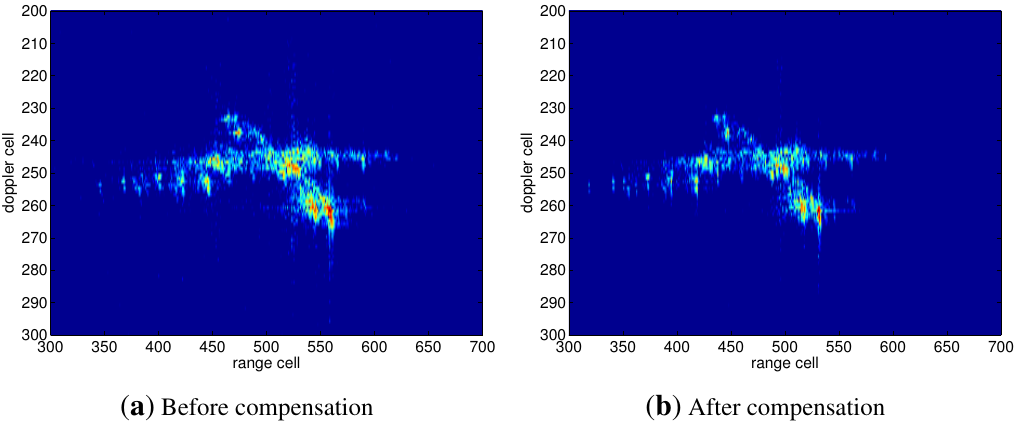
Figure 9. ISAR of the aircraft before and after speed compensation.